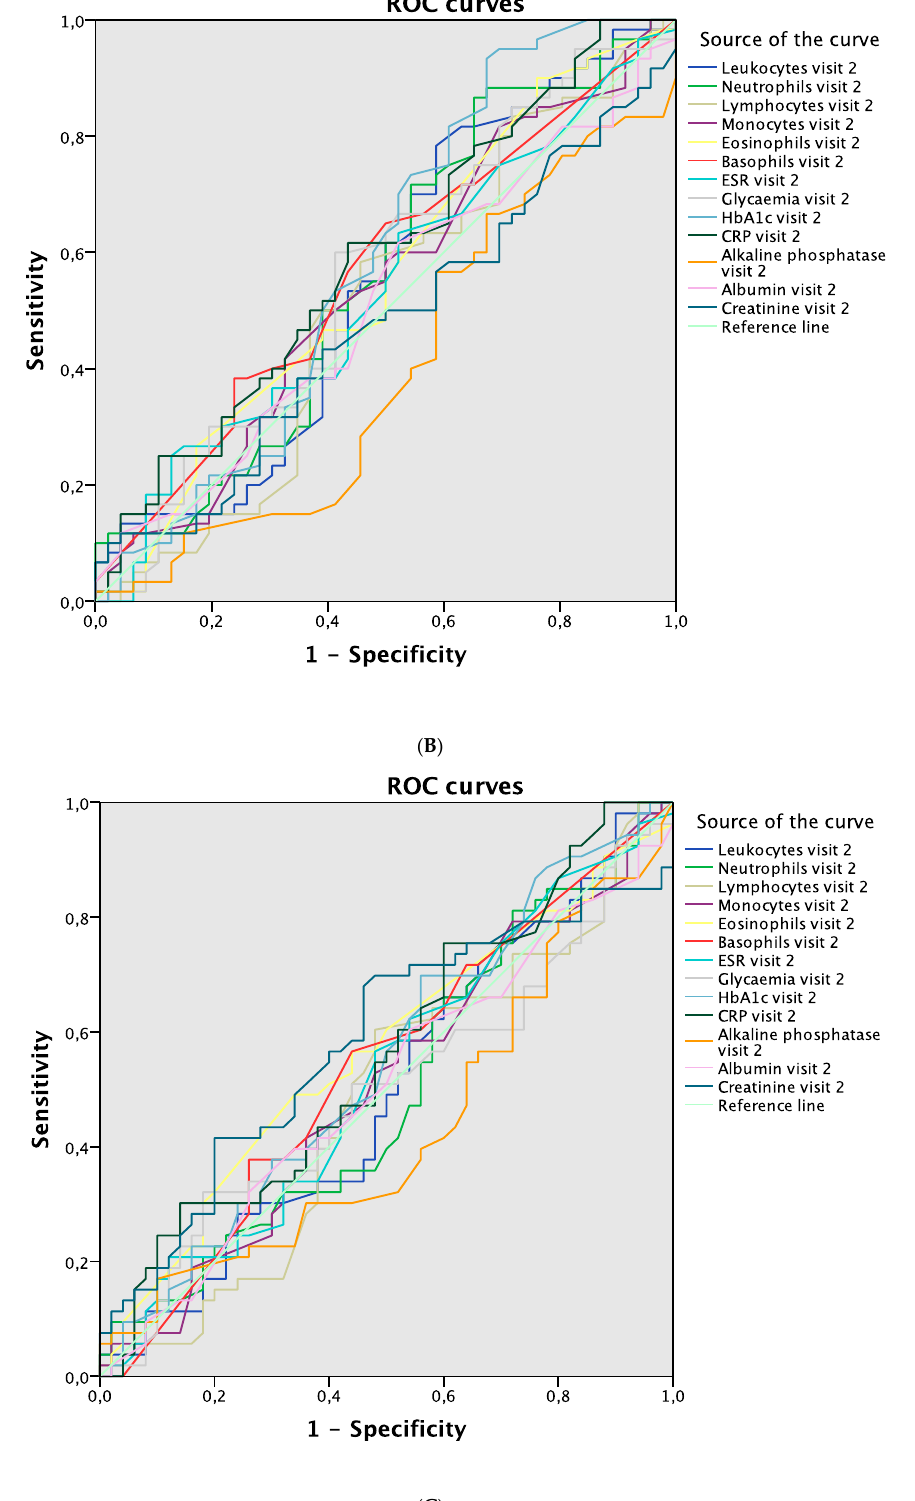
Figure 3. ROC curves. ( A ) Blood parameters in visit 2 associated with complications in visit 2. ( B ) Blood parameters in visit 2 associated with complications in visit 3. ( C ) Blood parameters in visit 2 associated with complications in visit 4. Abbreviations: ROC, receiver operating curve; ESR, erythrocyte sedimentation rate; HbA1c, glycosylated hemoglobin; CRP, C-reactive